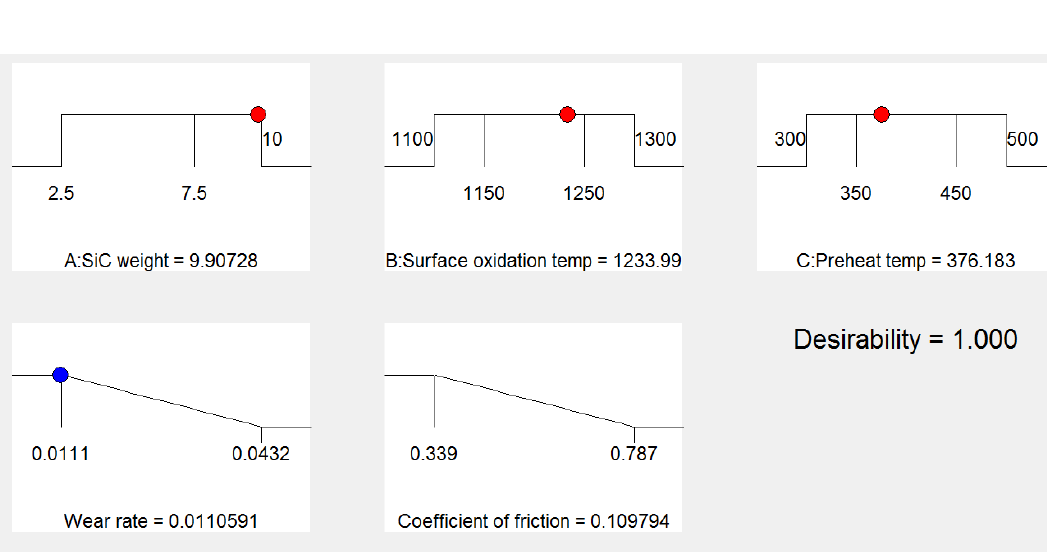
Figure 10: Ramp graph at optimal